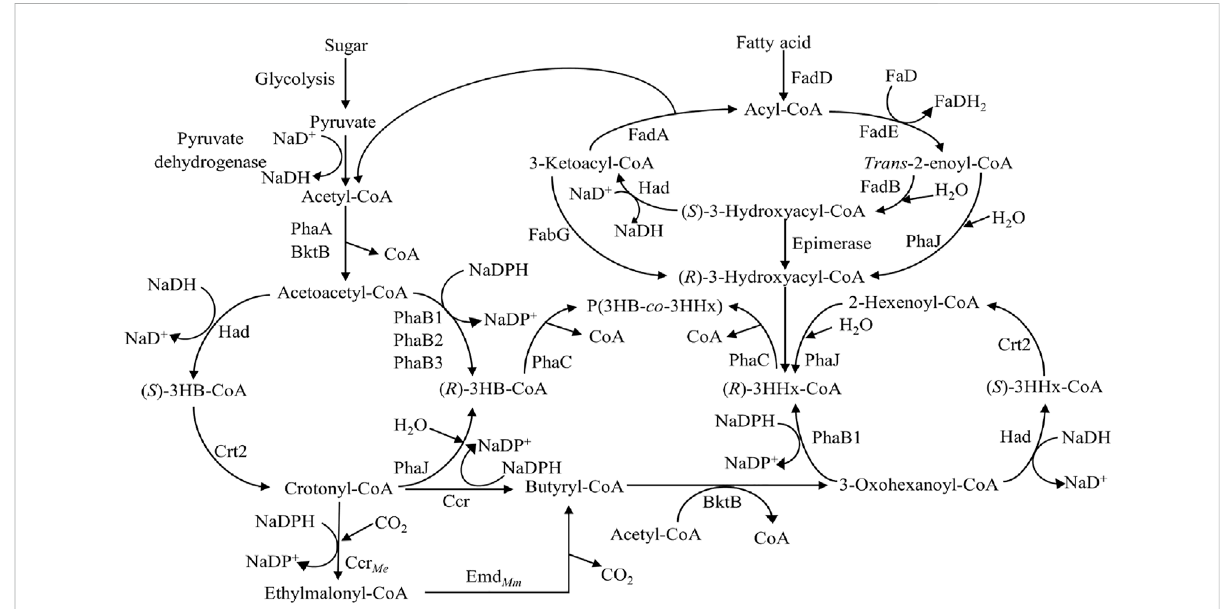
FIGURE 4 Metabolic pathway of P(3HB) and P(3HB- co -3HHx) production (Sudesh et al., 2000; Tsuge, 2002; Zhang et al., 2019). Abbreviation: PHA, polyhydroxyalkanoate; PhaA, β -ketothiolase; PhaB, NADPH-dependent acetoacetyl-CoA reductase; PhaC, PHA synthase; FadA, 3-ketoacyl-CoA thiolase; FadB, enoyl-CoA hydratase; FadD, acyl-CoA synthetase; FadE, acyl-CoA dehydrogenase; FabG, 3-ketoacyl-CoA reductase; 3HB-CoA, 3- hydroxybutyryl-CoA; 3HHx-CoA, 3-hydroxyhexanoyl-CoA; PhaJ, ( R )-speci fi cenoyl-CoAhydratase; Had,3-hydroxyacyl-CoA